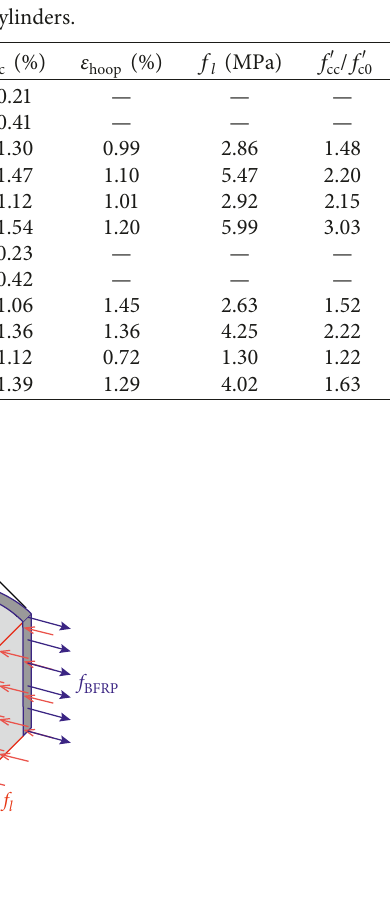
Figure 8: Schematic diagram of the confinement of BFRP Table 3: Coefficient of design-oriented confinement models.